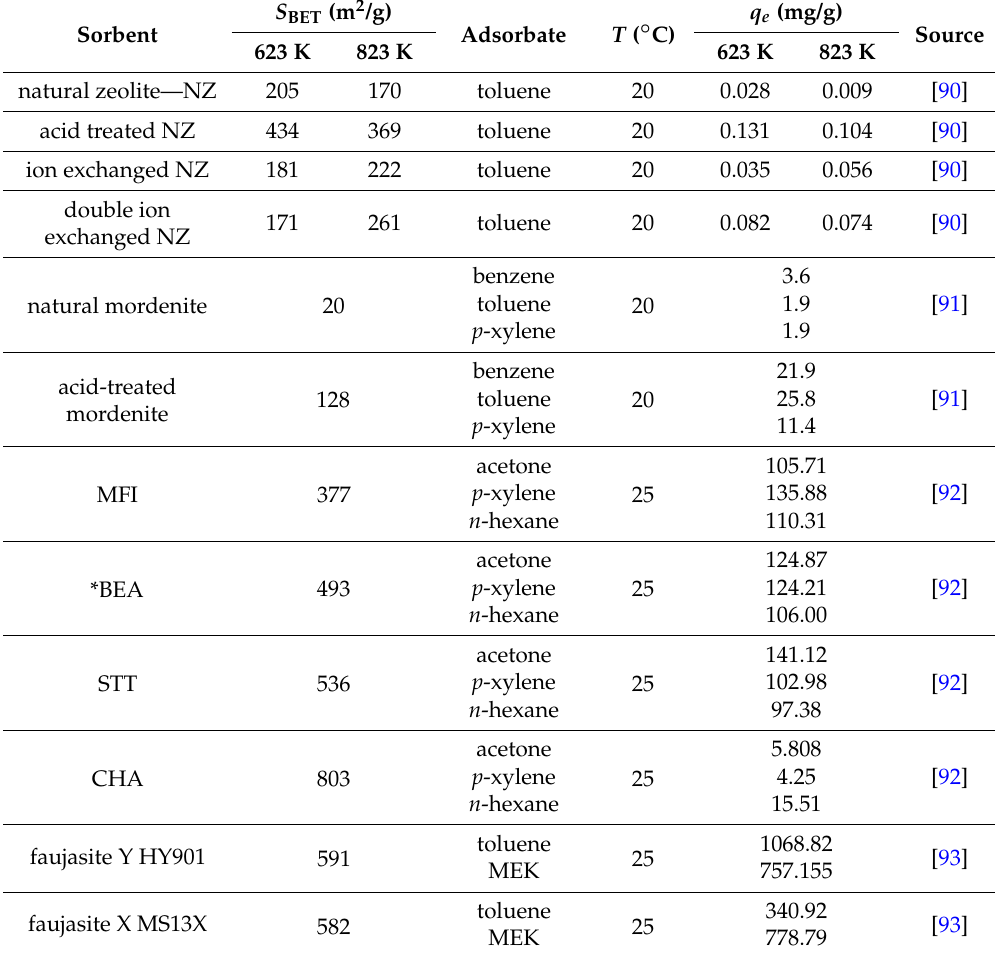
Table 3. Sorption capacities ( q e ) of selected adsorbents towards volatile organic compounds from gas